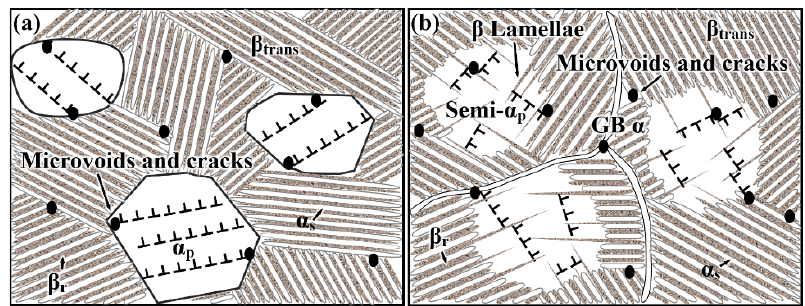
Figure 16. Schematic of the deformation and microvoids or cracks nucleation in different microstructures: ( a ) EM and ( b ) S-EM.